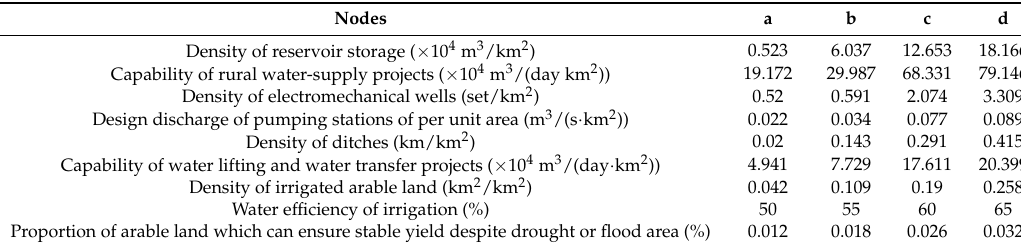
Table 4. Nodes of Assessment indexes.